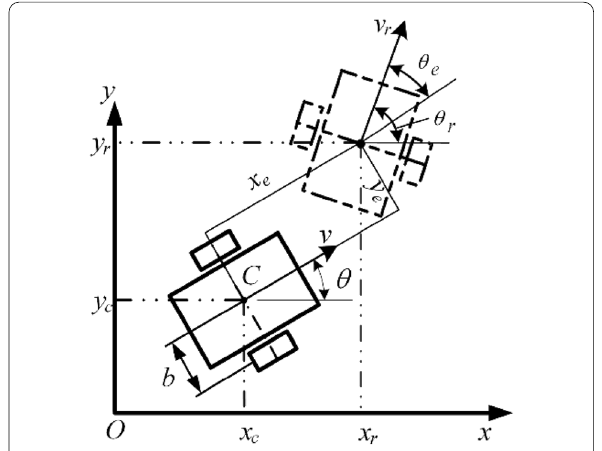
Figure 15 The diagram of path